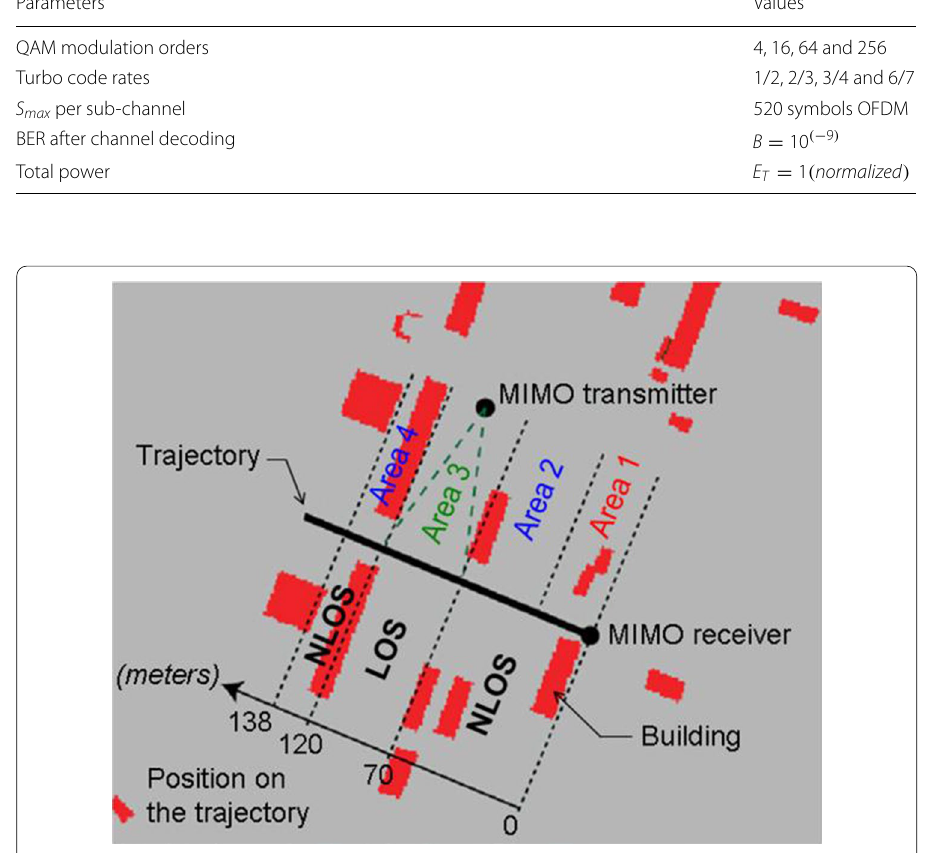
Fig. 11 Structure of the transmission environment. The realistic sub-urban area time and frequency selective channel used in the presented